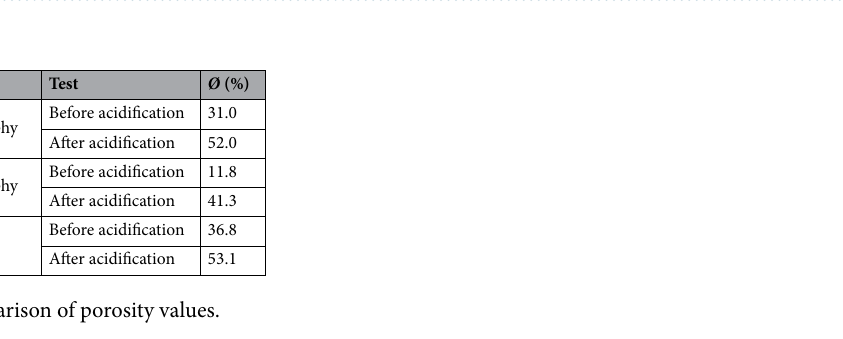
Figure 18. 3D structure of the ( a ) pre-degradation rock pore arrangement and ( b ) post-degradation sample pores.